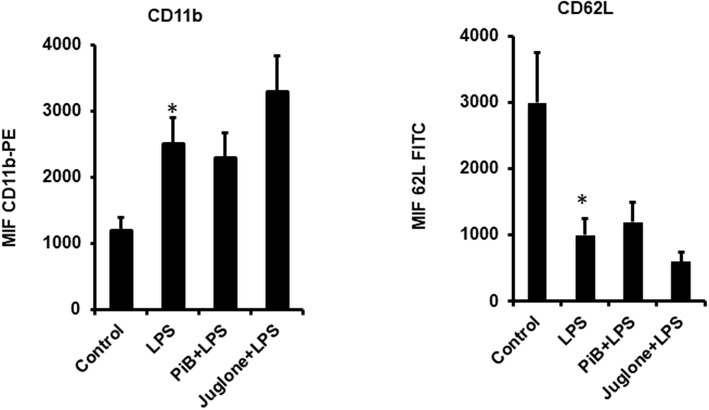
Effect of PiB and Juglone on LPS-induced CD11b expression on neutrophil plasma membrane and CD62L shedding. Human neutrophils (10 × 106/ml) were incubated in the absence or presence of PiB (50 μM) or Juglone (400 nM) for 20 min at 37°C, then treated by LPS (1 μg/ml) for another 20 min. CD11b (Left) and CD62L (Right) expression at the plasma membrane was determined by flow cytometry using specific antibodies. Data are mean ± SEM of three experiments. *p < 0.005 when LPS treated cells were compared to control untreated cells.